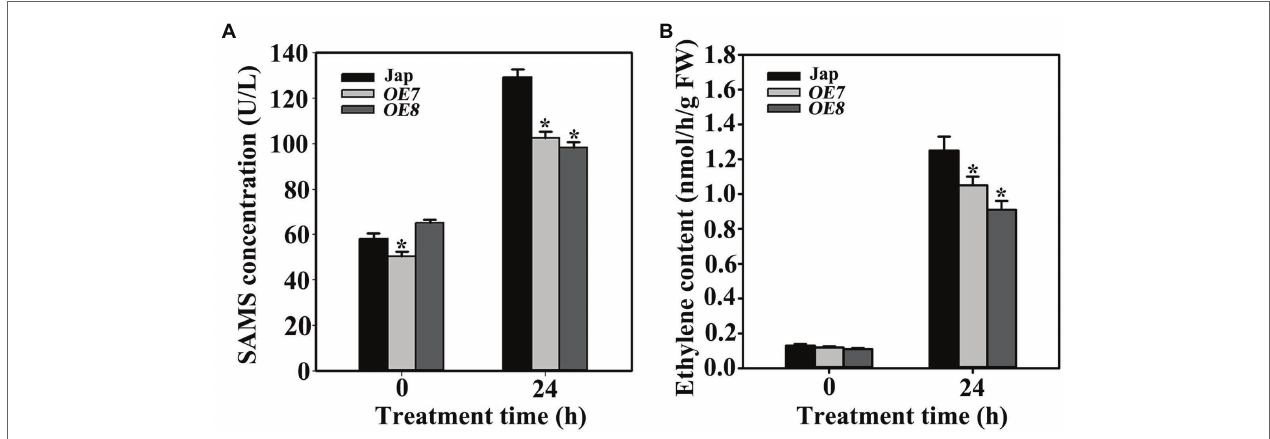
FIGURE 7 | OsWAK112 affects ethylene production under salt stress. (A) The amount of ethylene per gram fresh weight in 7-day-old Jap, OE7 , and OE8 seedlings grown under normal conditions or treated with 200 mM NaCl for 24 h. (B) The SAMS contents of 7-day-old Jap, OE7 , and OE8 seedlings grown under normal conditions or treated with 200 mM NaCl for 24 h. In (A,B) , Student’s t- tests were conducted using data from transgenic seedlings compared to those from Jap. Asterisks indicate a significant difference at p <